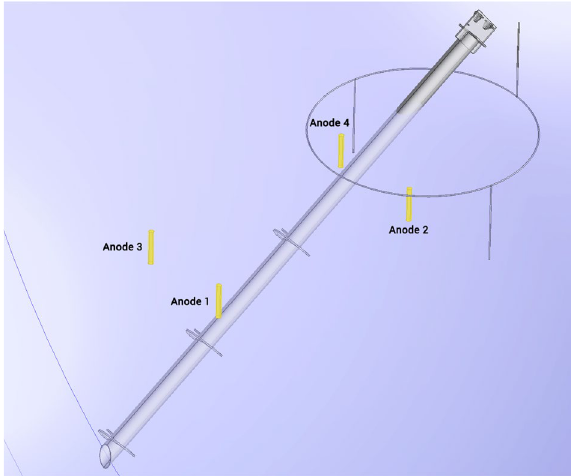
Figure 2. An anode bed with 4 × 17 lb high-potential magnesium anodes is considered for cathodic